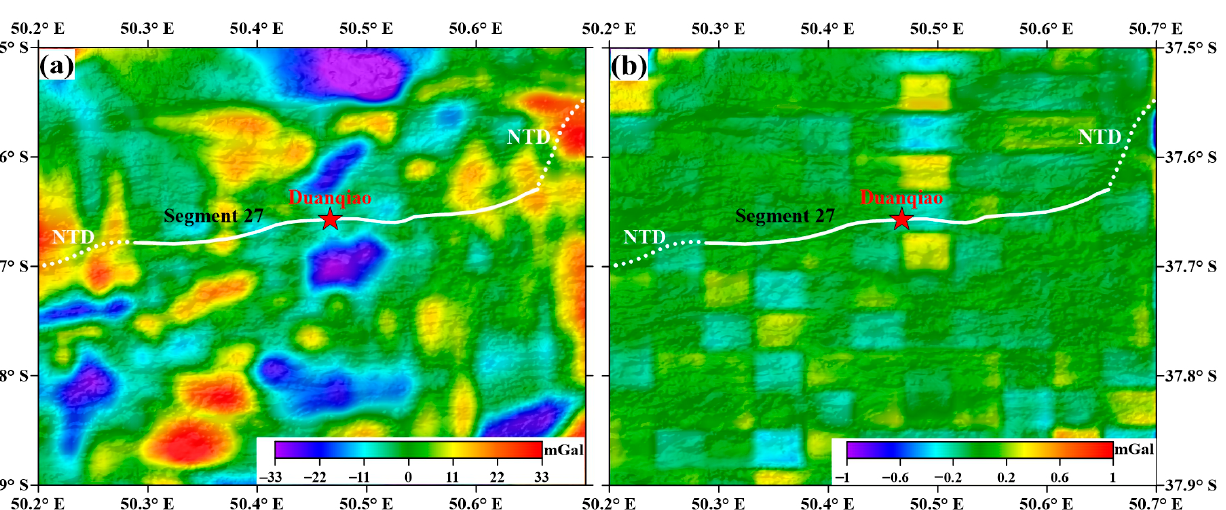
Figure 7. ( a ) Predicted data of inverted density model and ( b ) data misfit between the observed and predicted data. The solid white line and dotted white lines represent segment 27’s axis and two NTDs, respectively. The red star denotes the Duanqiao hydrothermal field [17].